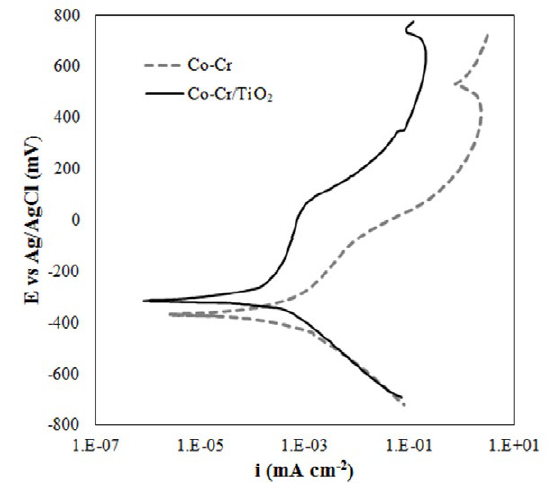
Fig. 4. Polarization curves of Co-Cr and Co-Cr/TiO 2 coatings after 1 h immersion in simulated body fluid.